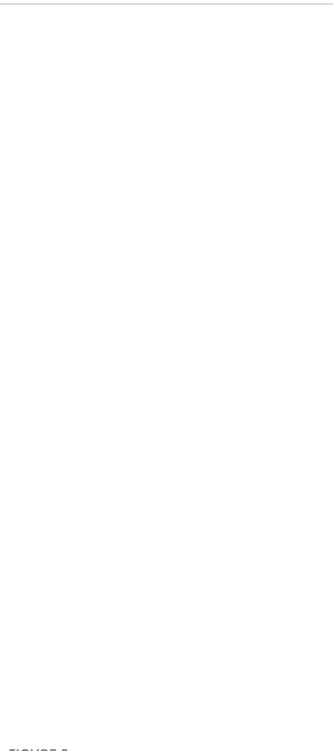
FIGURE 5 Activation of HIF1 promotes tumor glycolysis and promotes tumor deprivation of intestinal mucosal polyamines. (A) Detection of tumor glycolysis-related proteins in tumor-bearing mice with different levels of HIF1 a expression. (B) Quantitative data of (A) . ber group, * P < 0.05, ** P < 0.01 vs . HIF1 a (+/+) group. (C) The total polyamine concentration in the intestinal mucosa was determined by HPLC. HIF1a (+/+) group, ***P < 0.001 vs. control group; HIF1a OE group, ##P < 0.01 vs. HIF1a (+/+) group; HIF1a (-/-) group, ##P < 0.001 vs. HIF1a (+/+) group. (E) Detection of tumor polyamine metabolism-related proteins in tumor-bearing mice with different levels of HIF1 a expression. (F) Western blot quantitative data of (E) . ber group, * P < 0.05, *** P < 0.001 vs . HIF1 a (+/+)